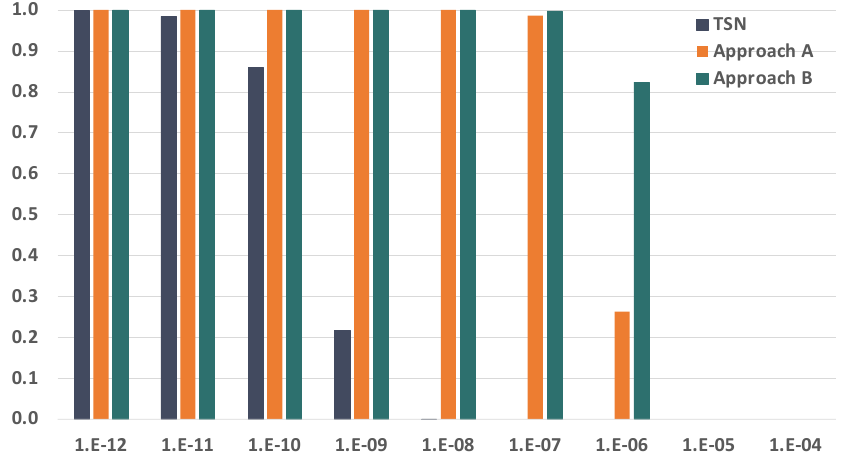
Figure 10. Reliability achievable when varying the BER from 1 × 10 − 12 to 1 × 10 − 4 . TSN is repre- sented in gray, approach A in orange and approach B in green. The x axis represents the BER values, while the y axis represents the